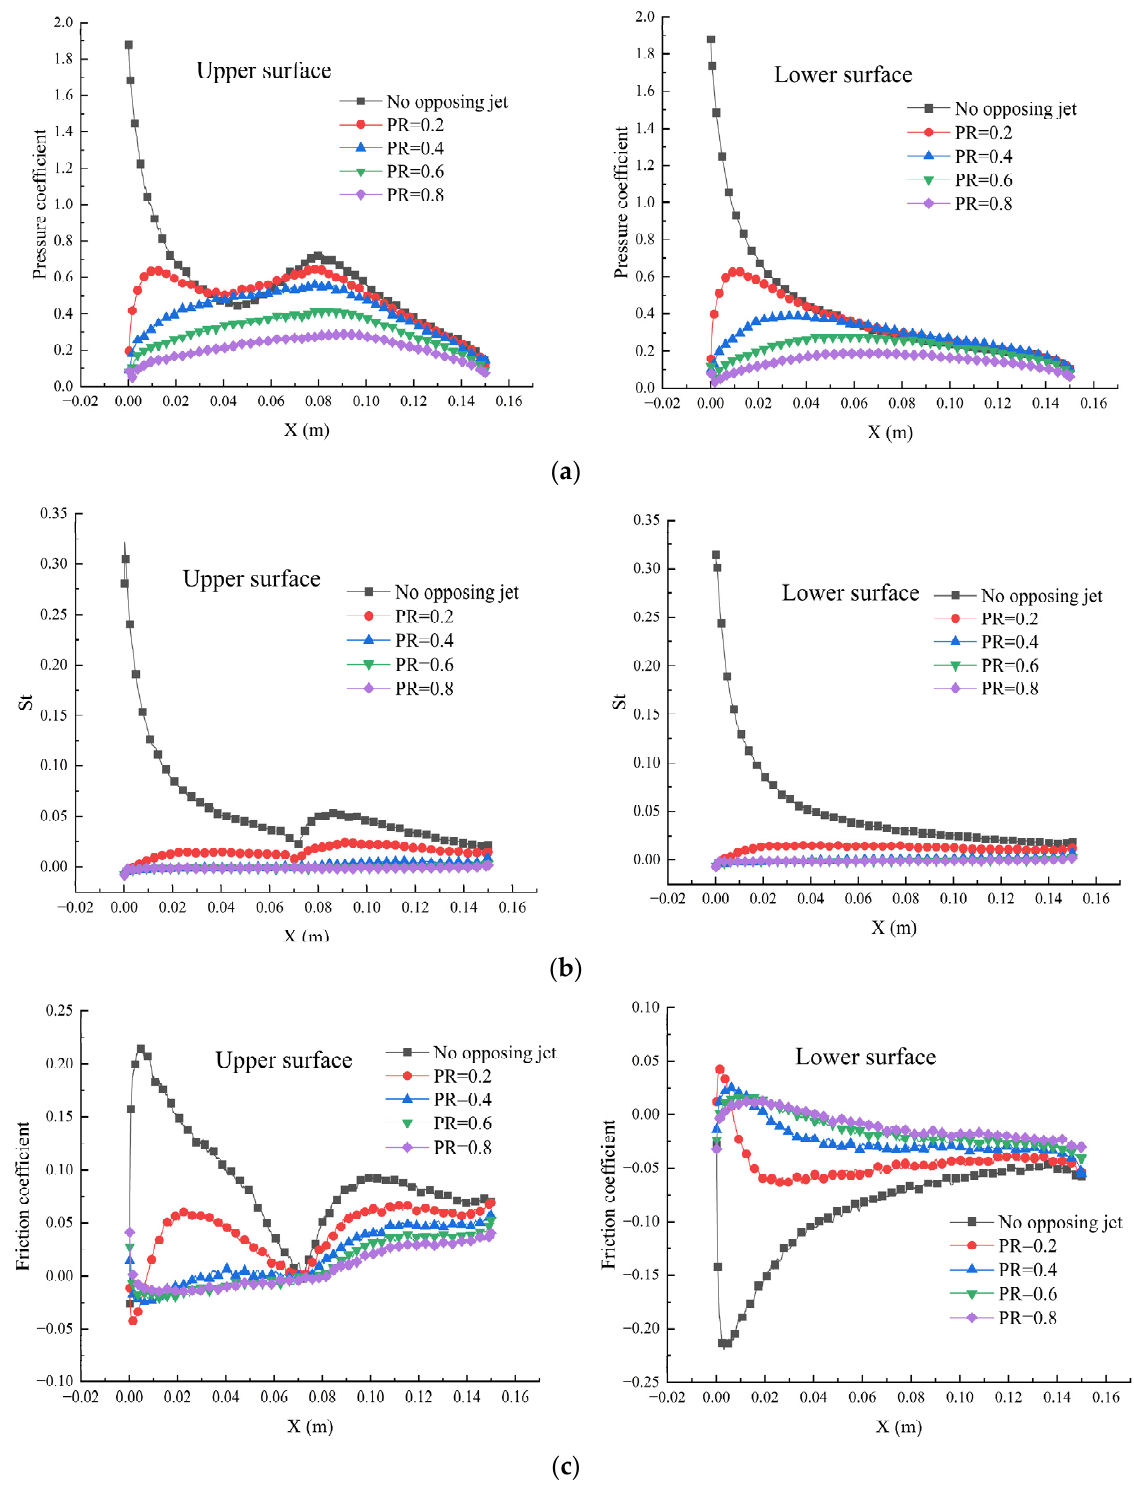
Figure 12. Double ellipsoid wall coefficient distribution: ( a ) Stanton number; ( b ) Pressure coefficient; ( c ) Friction coefficient.